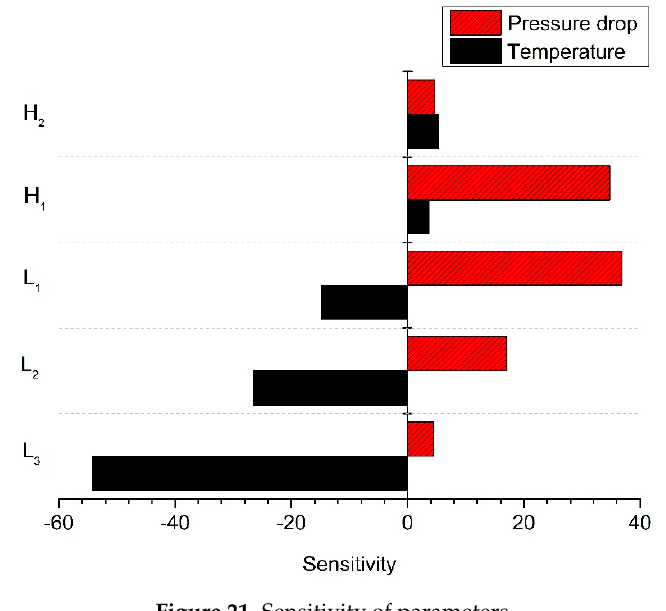
Figure 21. Sensitivity of parameters.